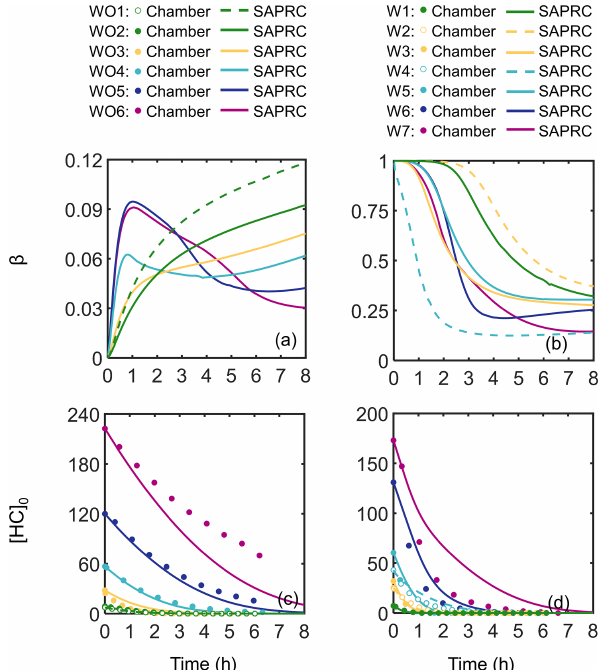
Figure 2. SAPRC-predicted β values: (a) without added NO x and (b) with added NO x . Measured (circles) and predicted (lines) cam- phene consumption as a function of irradiation time: (c) without added NO x and (d) with added NO x . The hollow makers used in (c) and (d) are equivalent to dashed lines defined in the